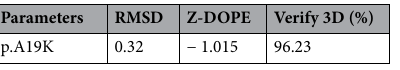
Table 1. Results of p.A19K Brazzein